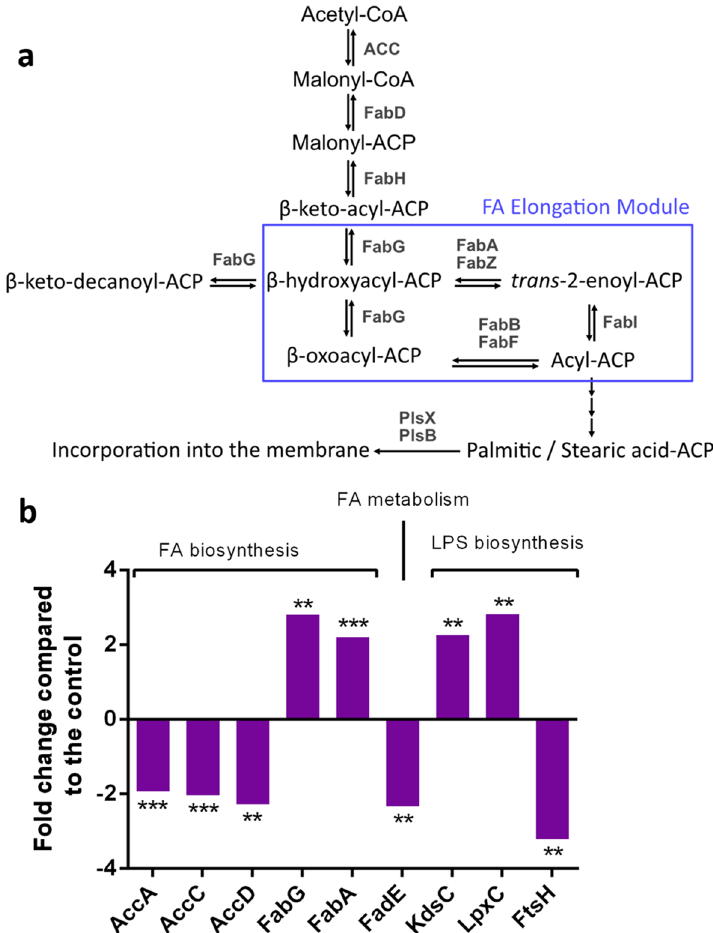
Figure 4. Modifications in the proteomic profile of MFAF76a relative to fatty acid and LPS biosynthesis and metabolism after exposure to 45 ppm of NO 2 . ( a ) Biosynthesis pathways of fatty acids in Pseudomonas spp . ( b ) Changes in the abundance of proteins involved in the synthesis and metabolism of fatty acids and lipopolysaccharide after exposure to 45 ppm of NO 2 . The proteins were identified using the P. fluorescens A506 strain as reference (N = 4). * = p < 0.05; ** = p < 0.01; *** = p <